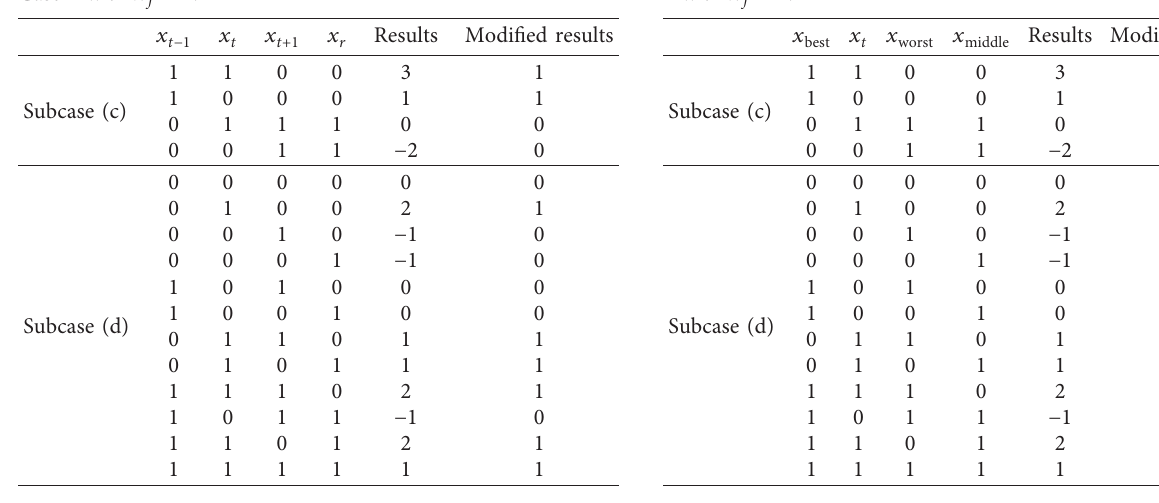
Table 9: Results of binary senior gaining and sharing stage of Case 2 with k f �